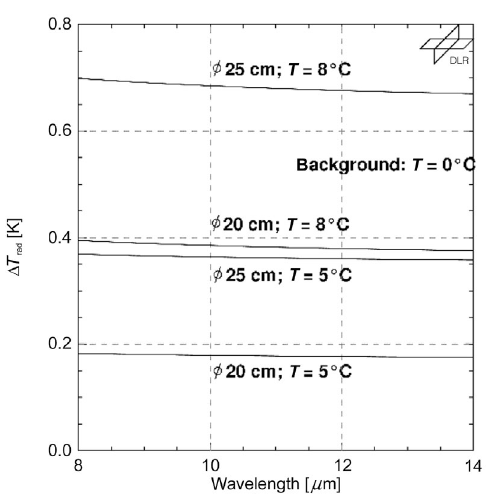
Fig. 13. Resulting temperature difference as func- tion of percentage of warm area referred to the cold background picture element.